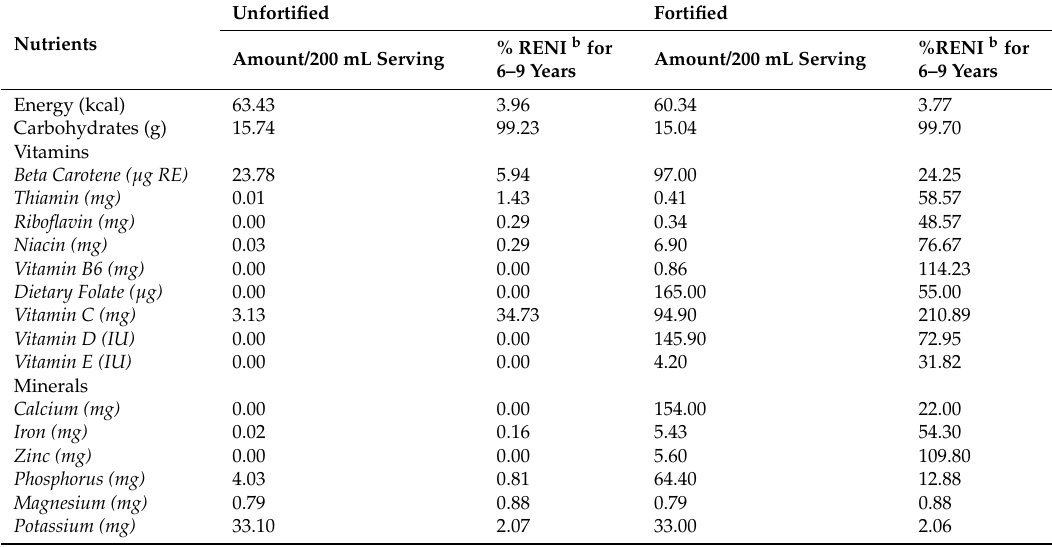
Table 1. Nutrient composition a of the unfortified and fortified